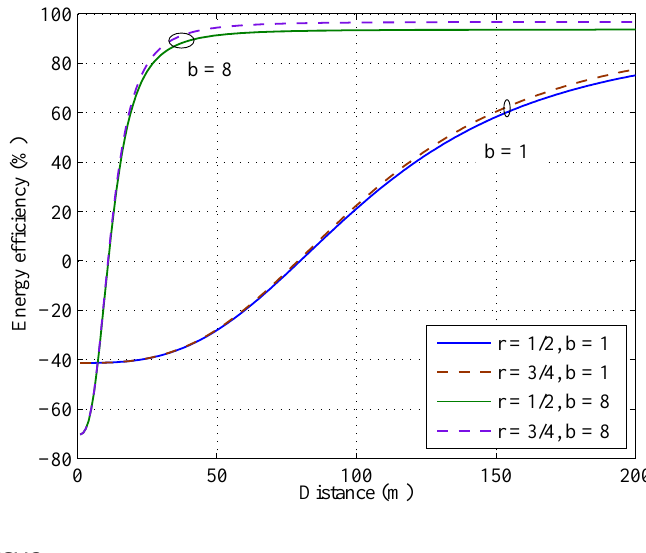
Figure 8. Energy efficiency for different constellation sizes.